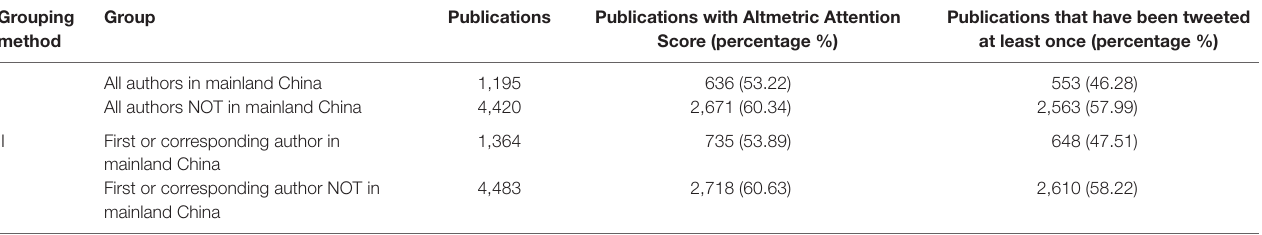
Table 1 | Two data grouping methods based on the location of authors’ affiliations.